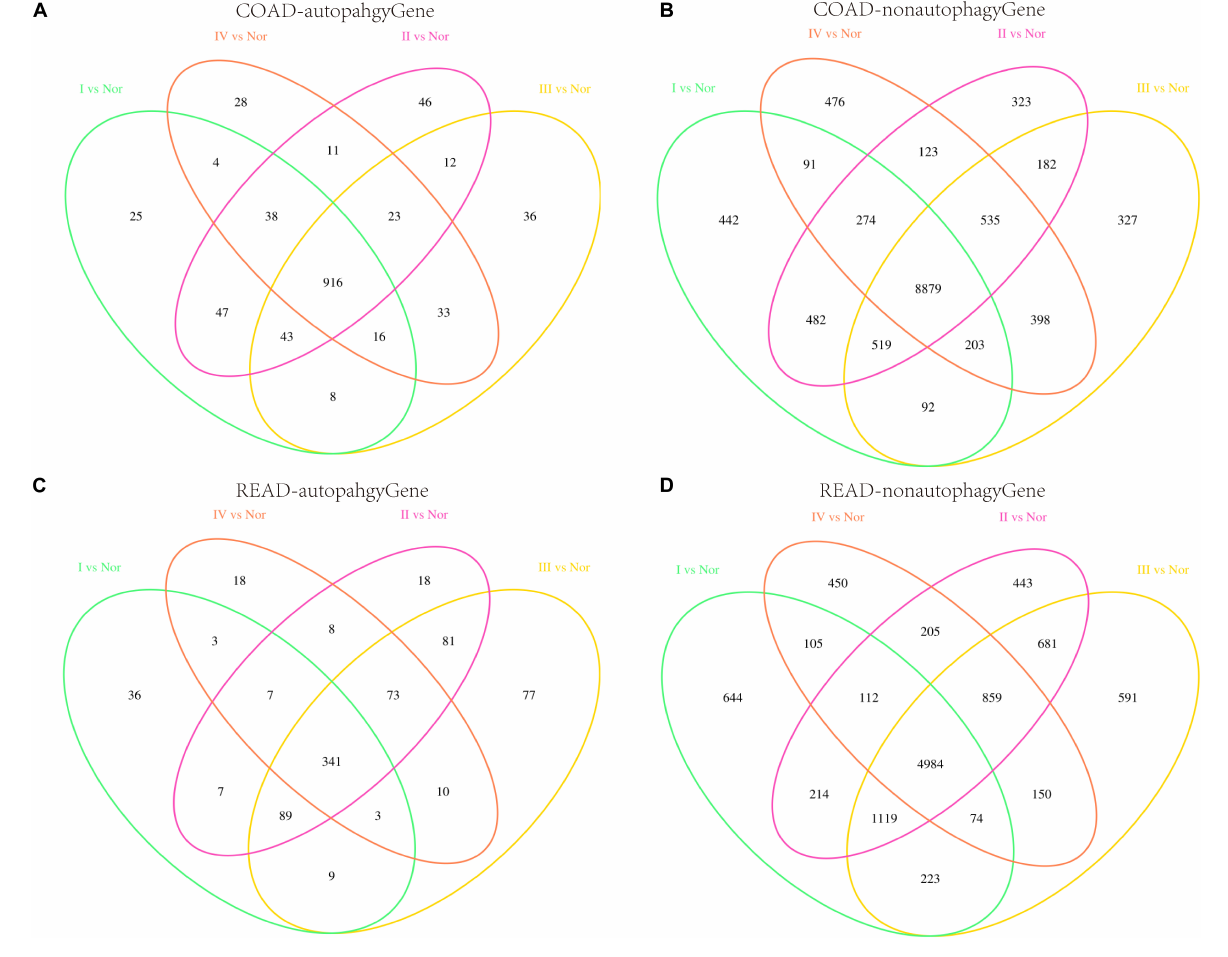
FIGURE 1 | Differentially expressed genes in the four stages. (A,B) Represent the Venn diagrams of differentially expressed autophagy genes and non-autophagy genes respectively in four stages of COAD. (C,D) Represent the Venn diagrams of differentially expressed autophagy genes and non-autophagy genes respectively in four stages of